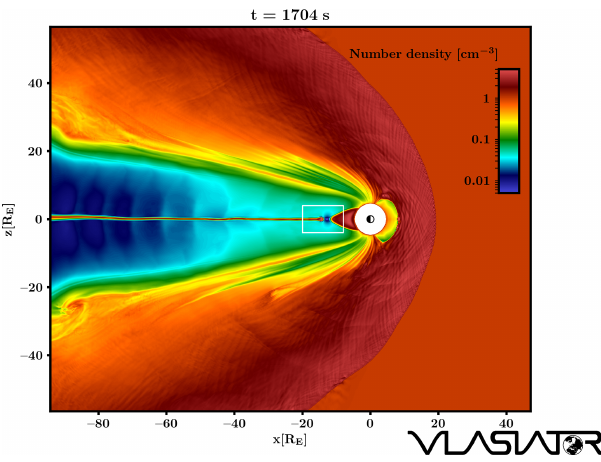
Figure 1. Overview of the Vlasiator simulation run investigated in this paper. Color coding depicts the proton number density at time t = 1704s from the beginning of the simulation. The plasma sheet shows that reconnection has begun shortly before the depicted frame. The white rectangle shows the area on which the subsequent figures will